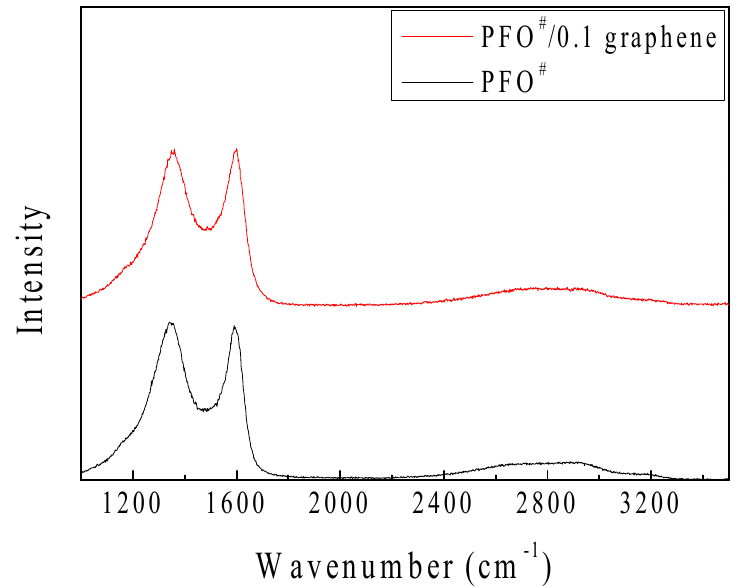
Figure 8. Raman spectra of PFO # -based carbon fibers; PFO # , PFO # /0.1 graphene .